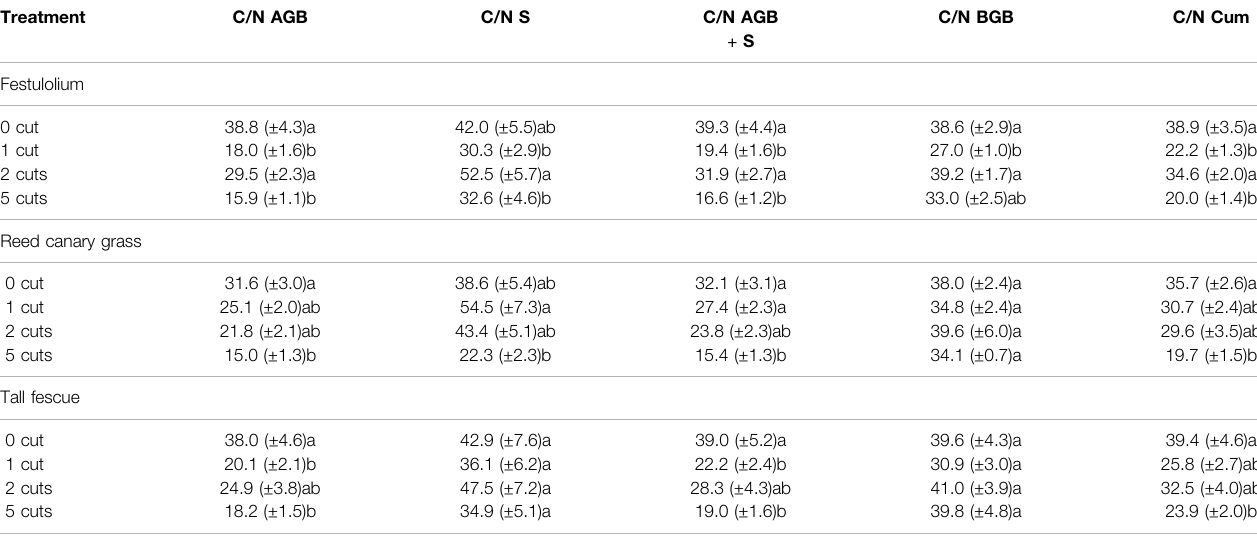
TABLE4| Carbon-to-nitrogen(C/N)ratiosinabovegroundbiomass(AGB),stubblebiomass(S),combinedabovegroundandstubblebiomass(AGB+S),andbelowground biomass(BGB),aswellasacrossallplantparts(cum)forthevarioustreatmentsandspecies.Lettersindicatedifferencesbetweentreatments,wheretreatmentswiththe same letters are not signi fi cantly different.